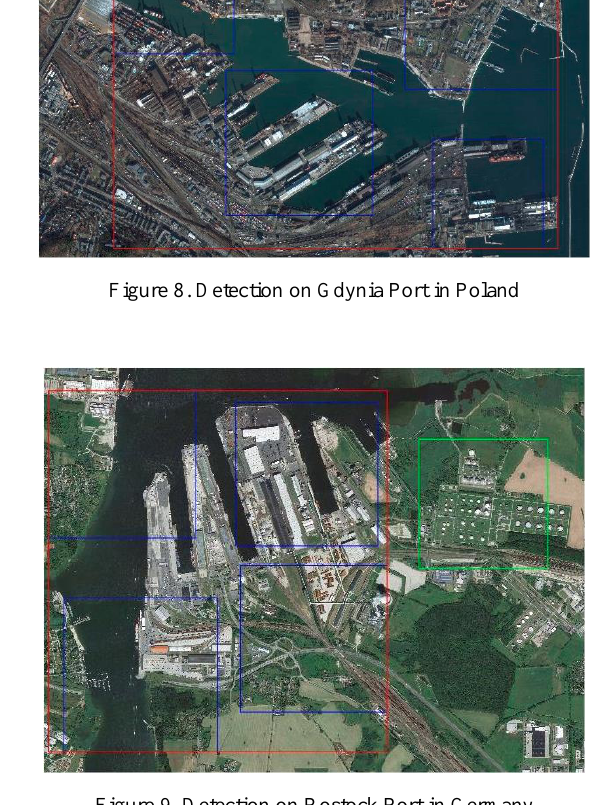
Figure 9. Detection on Rostock Port in